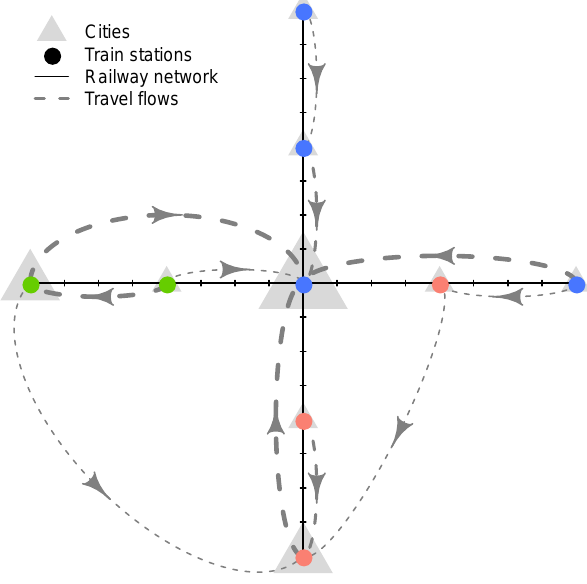
Figure 1. Illustration of railway network versus travel-demand network (city and travel flow symbols proportional to their size/volume; the color of each train station represents its